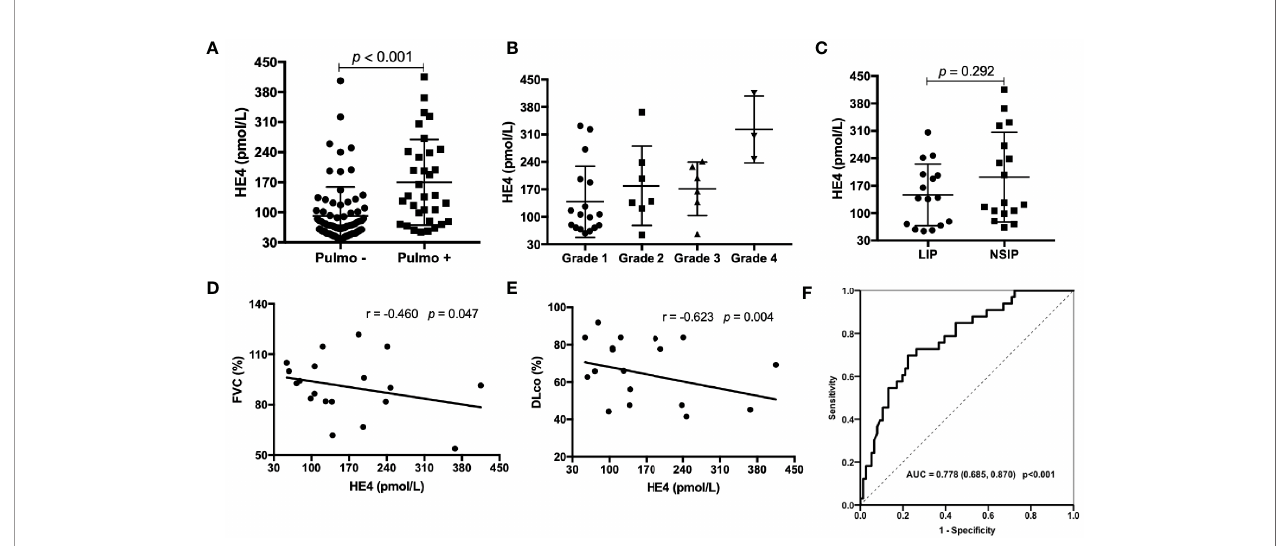
FIGURE 2 | Associations between the levels of HE4 and pulmonary involvements. (A) Patients with pulmonary involvement (n = 33) had higher levels of HE4 than those without pulmonary involvement (n = 76). (B) Serum levels of HE4 in patients with ILD according to semiquantitative CT grades: grade 1 (n = 17); grade 2 (n = 7); grade 3 (n = 6); grade 4 (n =3 ). (C) Serum HE4 was similar between the groups of LIP (n = 16) and NSIP (n=17). (D, E) HE4 was negatively correlated with FVC% and DLCO% (n = 19). (F) Receiver operating curve (ROC) analysis on the clinical performance of HE4 in identifying patients with pulmonary involvement.